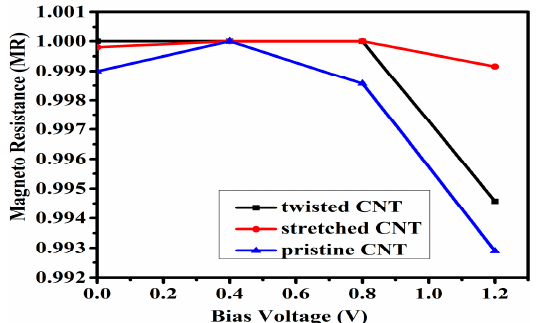
Figure 8. Comparative plots for magneto resistance with respect to applied voltages. For high bias voltage, MR of stretched CNT is higher than that of twisted CNT, and MR of twisted CNT is higher than that of pristine CNT.